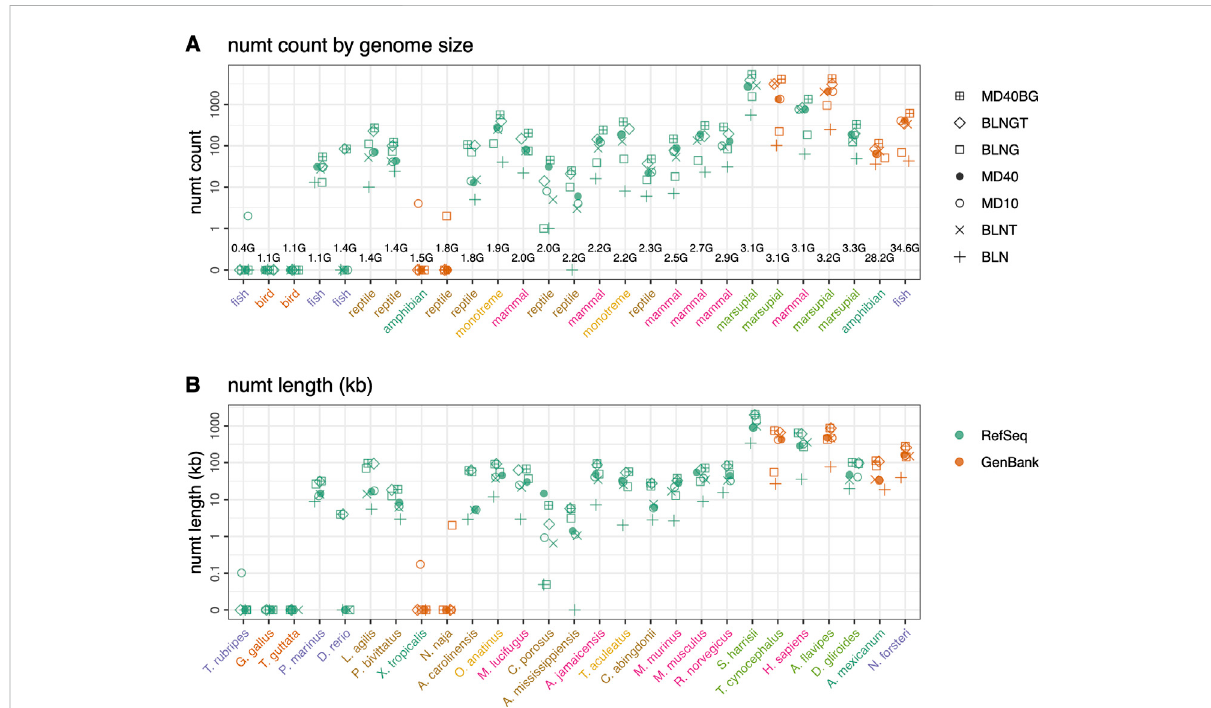
FIGURE 5 Mitochondrial nuclear transfer across vertebrate genomes. (A) Total numt counts and (B) total numt length (kb) for the 7 different similarity searches ordered by genome size (GB) from smallest to largest. Genome sizes are listed in the top panel and species are listed on the bottom panel but are consistent for both panels. GenBank mtDNA genomes colored in orange and RefSeq mtDNA genomes colored in green. Scienti fi c names shown in panel B are colored by vertebrate classes shown in panel (A) . Numt counts (A) and lengths (B) for each species for the 7 different similarity searches run are shown as follows: 1) plus sign (+): coding sequence queries — BLASTN DNA:DNA with “ -task megablast ” default option (BLN); 2) (x): coding sequence queries — BLASTN DNA:DNA with “ -task blastn ” option (BLNT); 3) open circle: coding sequence queries — TFASTX protein:translated-DNA searches with the MD10 protein scoring matrix (MD10); 4) fi lled circle: coding sequence queries — TFASTX protein: translated-DNA searches with the MD40 protein scoring matrix (MD40); 5) open square: whole mtDNA genome queries — BLASTN DNA:DNA